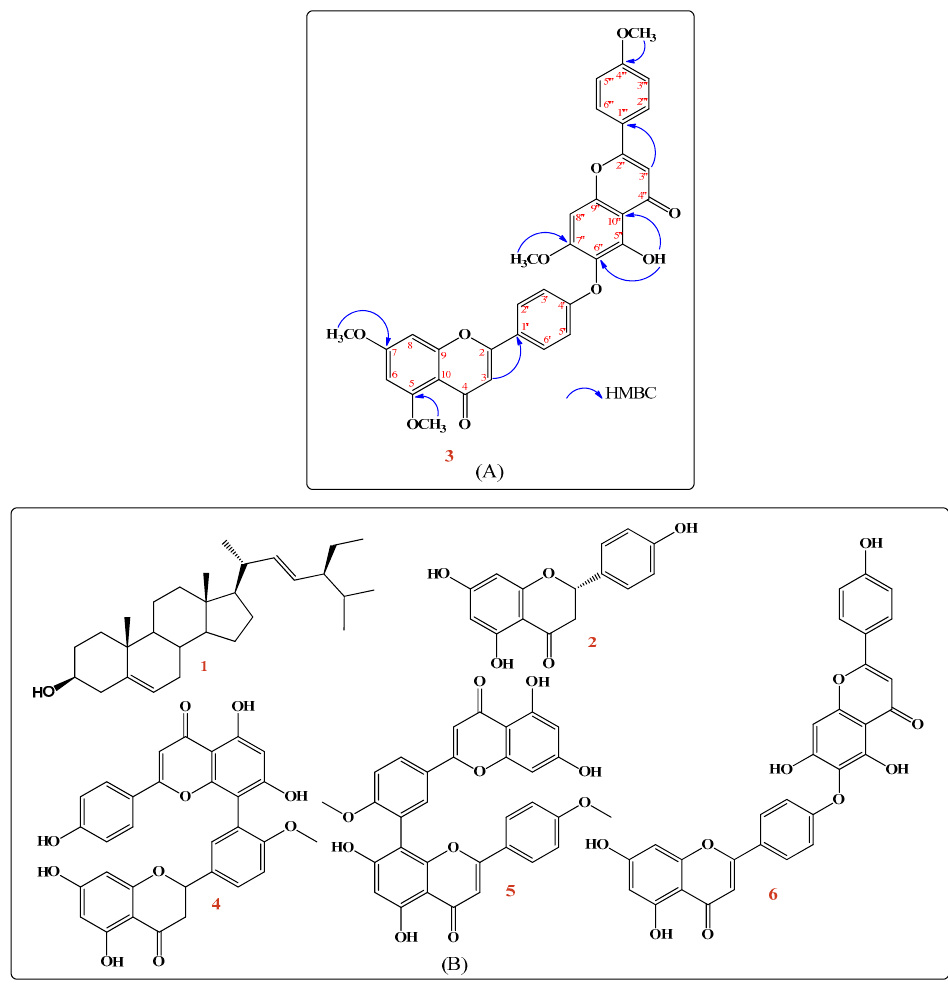
Figure 1. ( A ): The chemical structure of the new compound ( 3 ) showing HMBC correlations. ( B ): The chemical structures of isolated pure compounds.